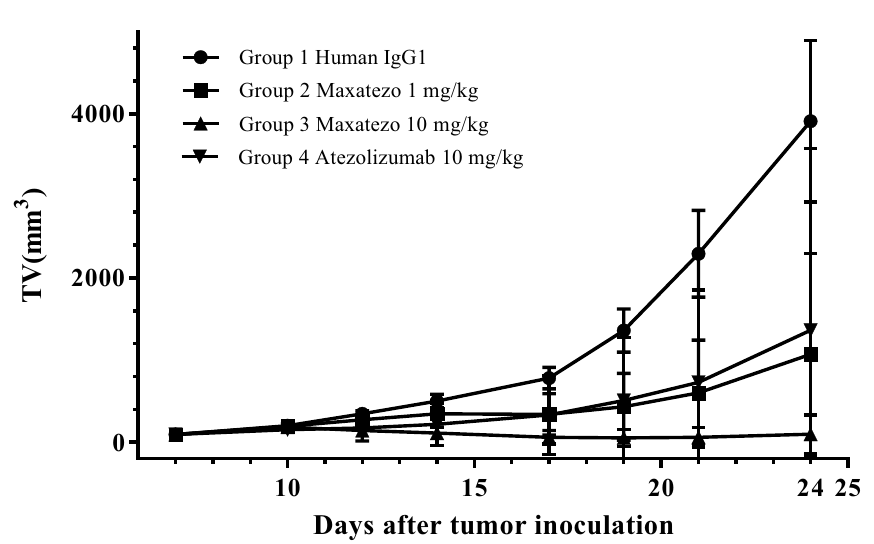
Figure 6. Maxatezo has stronger anti- tumor activity in vivo . MC38 cells were injected subcutaneously into C57BL/6 mice (n = 8). On day 7, the animals were randomly grouped and treated with Maxatezo (1 mg/kg, 10 mg/kg), Atezolizumab (10 mg/kg) and human IgG1 a control every 3 days. The plots show changes in tumor volume over time in Maxatezo-treated versus Atezolizumab-treated mice. The data are presented as mean ± SD. The horizontal coordinate represents the days after tumor inoculation and the vertical coordinate represents the tumor volume (mm 3